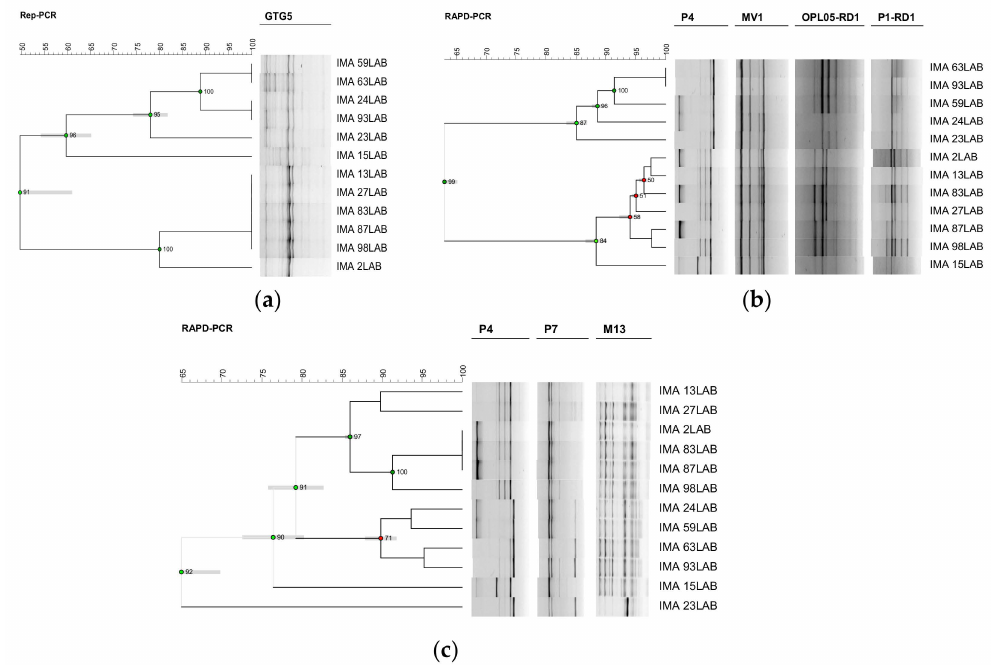
Figure 1. Screening of the best discriminating tool carried out on 12 selected L. sanfranciscensis isolates characterizing Protected Designation of Origin (PDO) Tuscan bread sourdough. Dendrograms obtained from unpaired group method with arithmetic average (UPGMA) analysis, using Dice’s coe ffi cient, of (GTG) 5 repetitive element sequence based-polymerase chain reaction (rep-PCR) profiles ( a ), of combined random amplified polymorphic DNA (RAPD)-PCR profiles, obtained using P4, MV1, OPL-05 + RD1 and P1 + RD1 primers ( b ) and using P4, P7 and M13 primers ( c ). The scale indicates the similarity level. Cophenetic correlation is shown at each branch by numbers and coloured dots, ranging between green-yellow-orange-red, according to decreasing